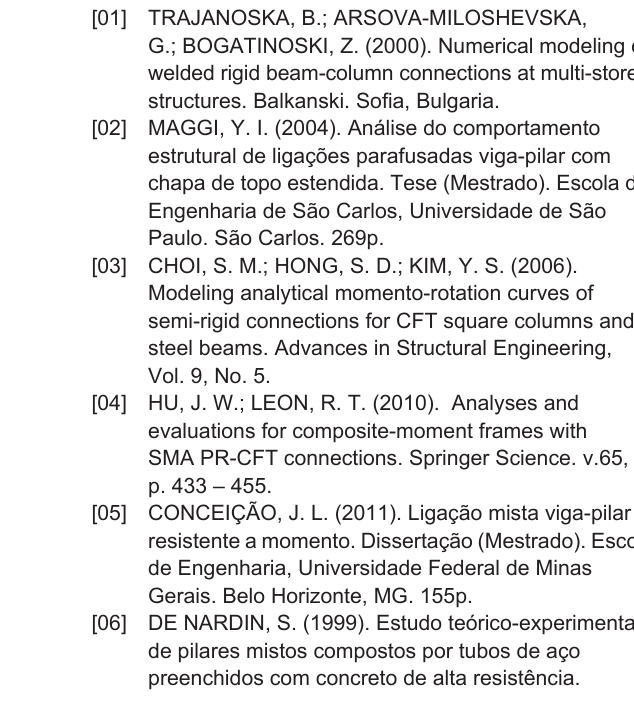
Bending moment versus rotation